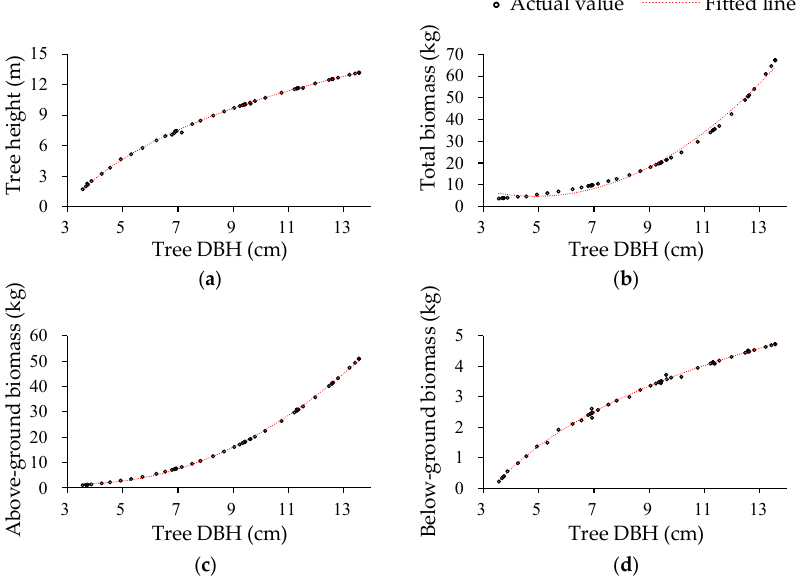
Figure 8. Under adequate drip irrigation treatment, scatter plots with fitted curves were constructed for some tree diameter at breast height (DBH) data as follows: ( a ) the fitted curve of DBH and tree height data; ( b ) the fitted curve of DBH and total biomass (excluding leaves and defoliation); ( c ) the fitted curve of DBH and above-ground biomass (including only trunk and branches); ( d ) the fitted curve of DBH and below-ground biomass.